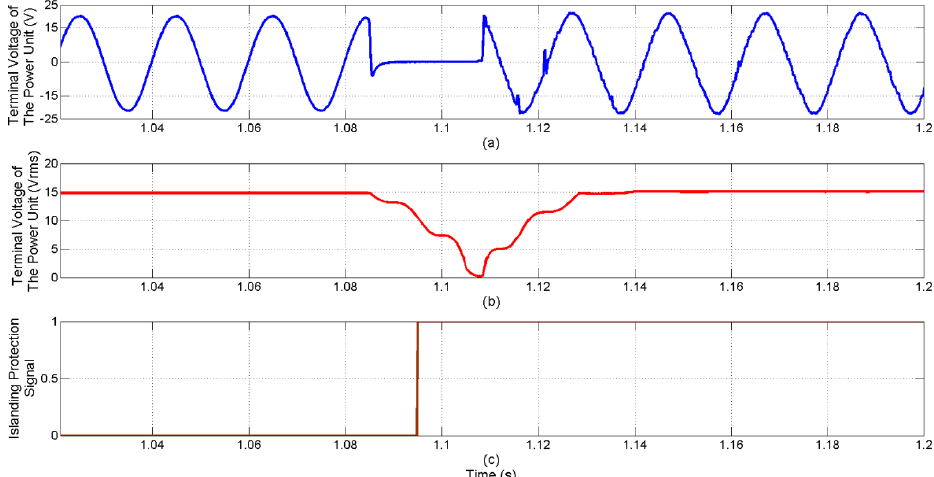
Figure 14. The waveform of the terminal voltage of the power unit when the power grid fails. ( a ) Terminal voltage of the power unit [V] ( b ) Terminal voltage of the power unit [Vrms] ( c ) Islanding protection signal.